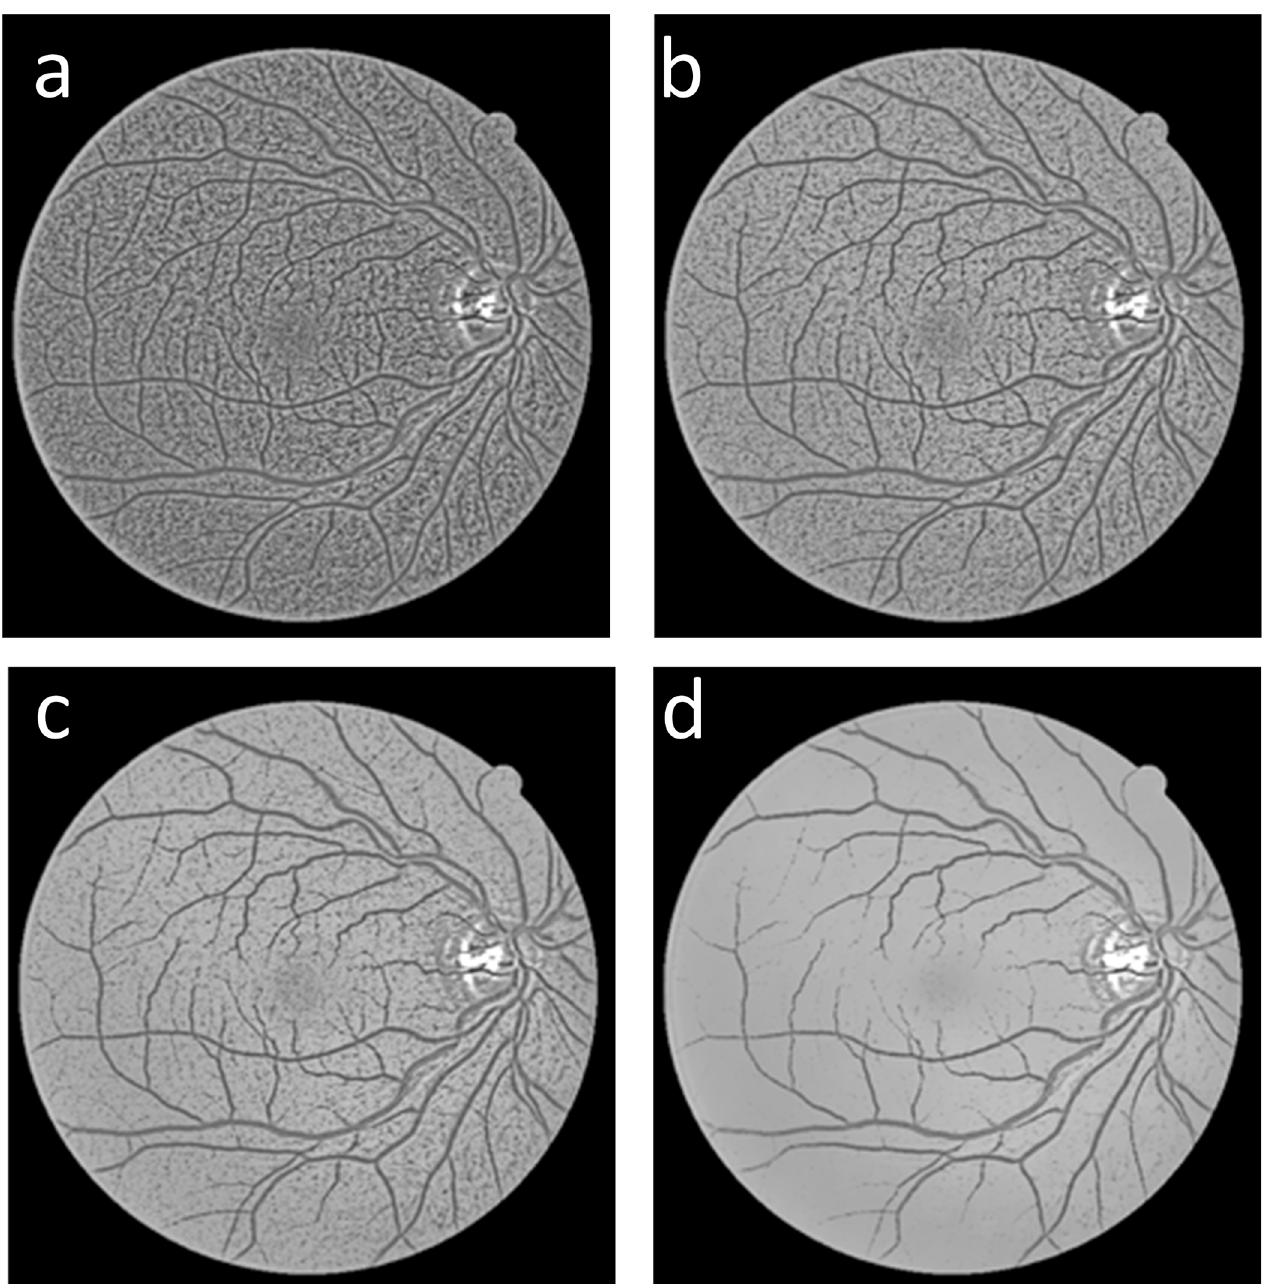
Fig 6. (a-d) Blood vessel detection using the proposed gray-voting algorithm with different values of k: (a) k = 0; (b) k = 3; (c) k = 5; and (d) k = 10.